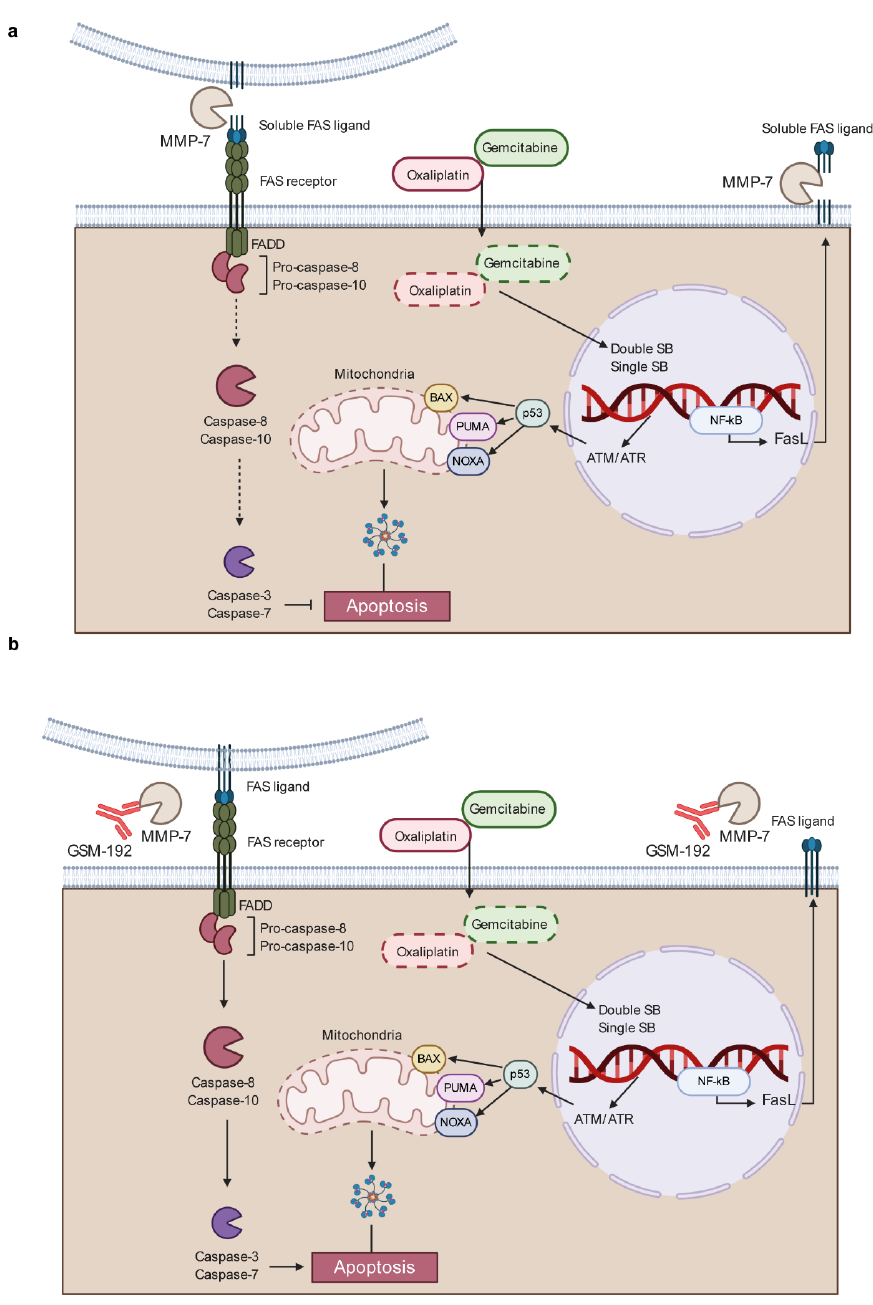
Figure 5. Schematic representation of the link between chemoresistance and MMP-7 shedding of Fas ligand. ( a ) DNA chelating chemotherapy agents including oxaliplatin and gemcitabine create double and single strand breaks